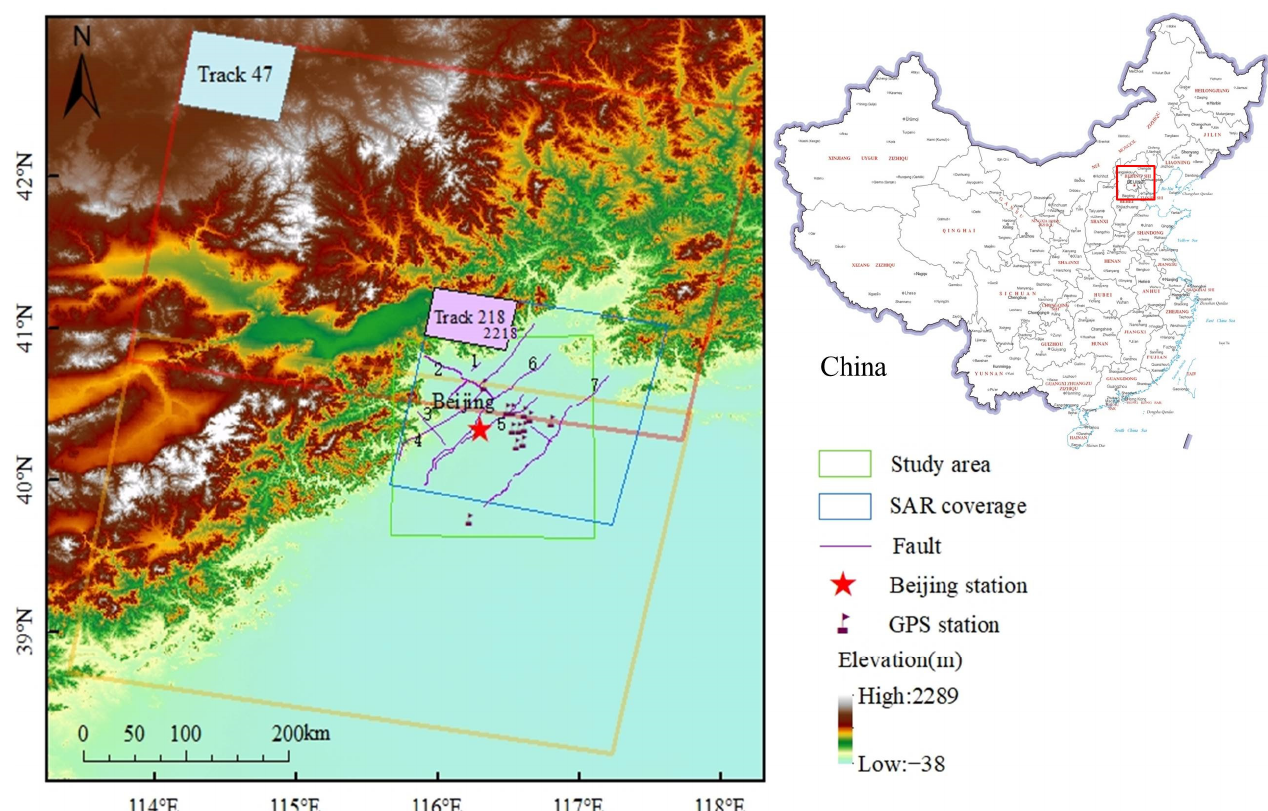
Figure 1. Study area geographical location and coverage of the Synthetic Aperture Radar (SAR) data. In the background is the shaded terrain-generated digital elevation model (SRTM DEM) of the Shuttle Radar Topography Mission. The red and yellow rectangles represent the coverage of sentinel-1 SAR data, the blue indicate coverage of ENVISAT ASAR data, and the green rectangle represents the location of the study area. The Beijing Plain is mainly controlled by northeast and northwest direction active faults. The northeast direction fault systems are composed mainly of the Xiaotang Mountain (1), Huangzhuang-Gaoliying (4), Tongxian-Nanyuan (5), Shunyi-Liangxiang (6), and Xiadian (7) faults. The northwest direction fault systems are composed mainly of the Nankou Sunhe (2) and the Yongding River (3) faults. The figure in the upper right corner shows the location of the study area in China. It can be downloaded from http://bzdt.ch.mnr.gov.cn/index.html, accessed on 12 January 2022. The part of the red rectangle in the map corresponds to the figure on the left.